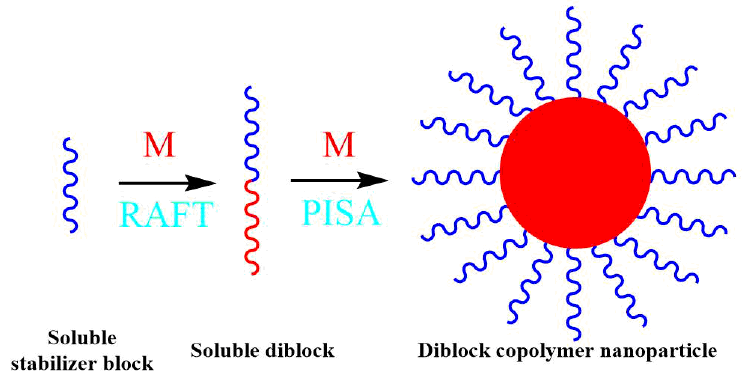
Figure 11. Schematic representation of the self-assembly process in polymerisation-induced self- assembly